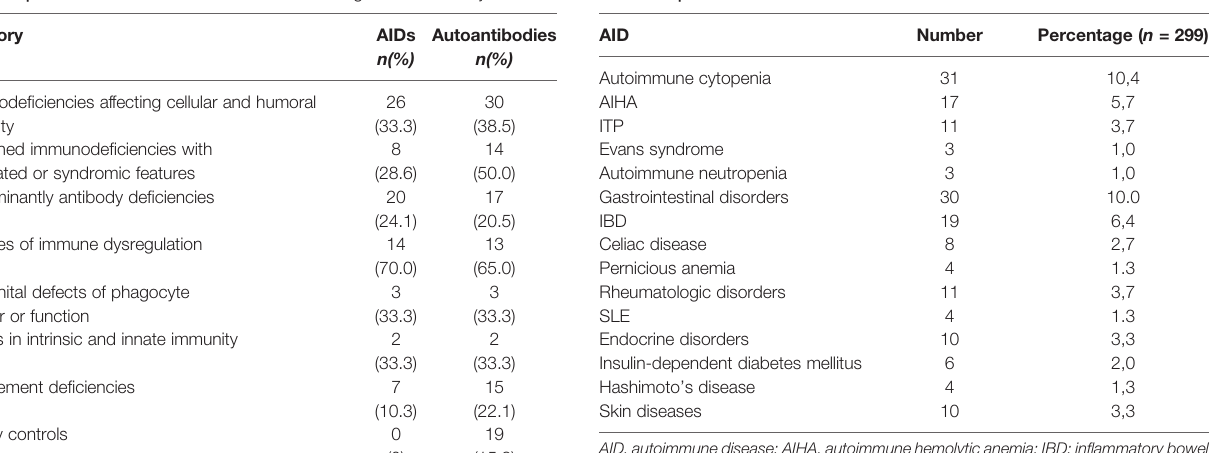
TABLE 3 | AID and autoantibodies in different PID categories and healthy controls. TABLE 4 | Main autoimmune manifestations in our